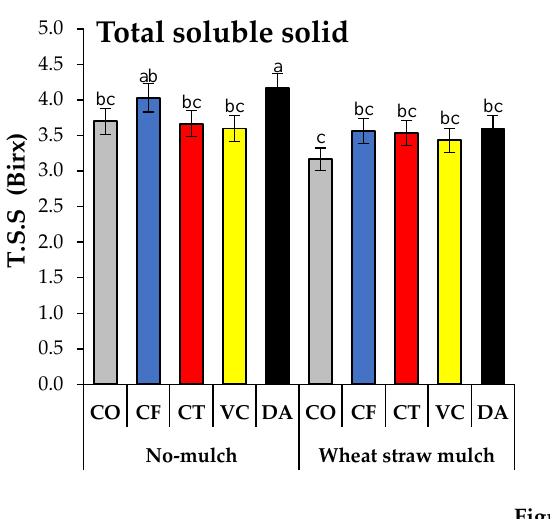
Fruit Weight (g Fruit − 1 )Mulching Fertilizers